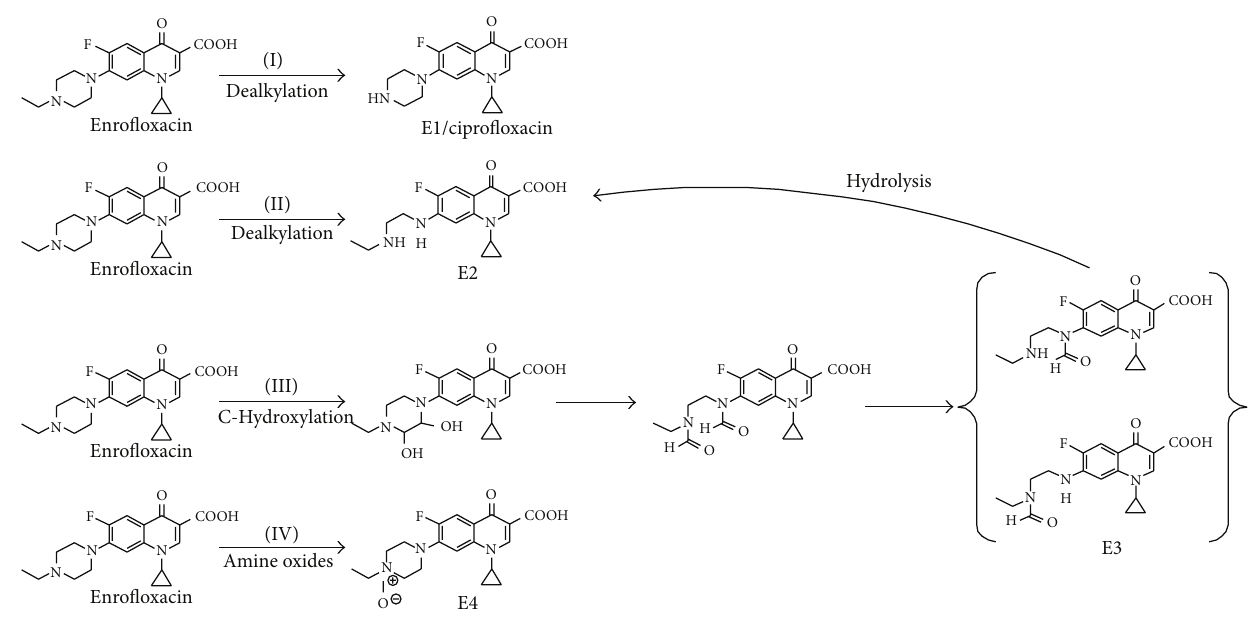
Figure 2: Proposed reaction pathways and products in the oxidation of ENR by Mn(VII).